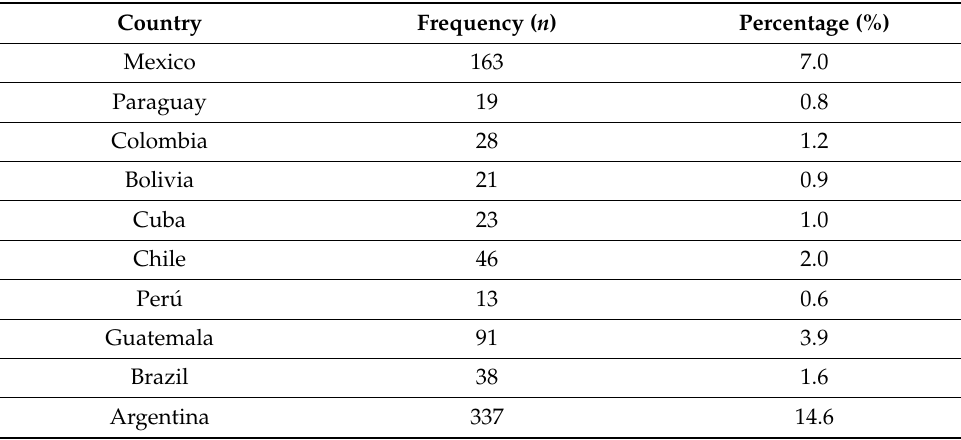
Table 1. Distribution of the study sample according to participating